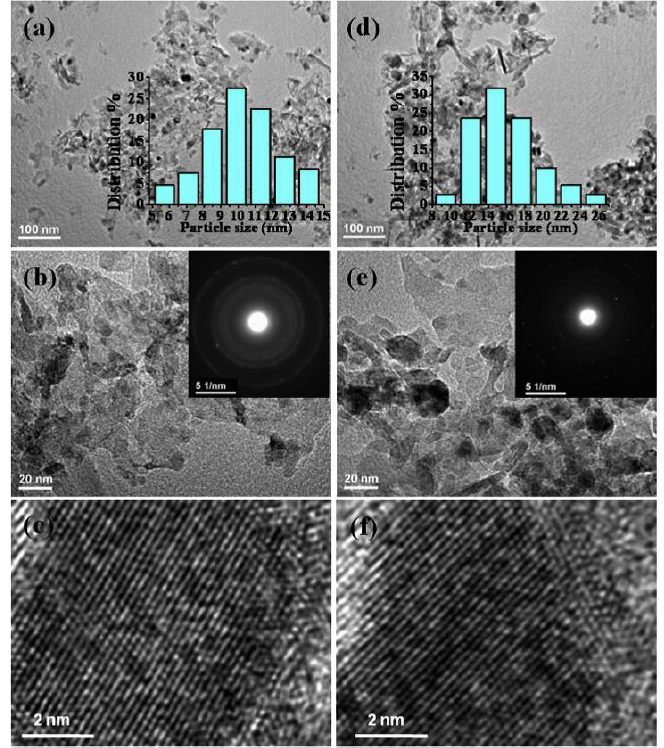
Figure 3. TEM, HRTEM, and SAED patterns of Ni/Al 2 O 3 prepared under MW radiation ( a – c ) and without MW irradiation ( d – f ). Reprinted from Int. J. Hydrogen Energy , 42, Song, F.; Zhong, Q.; Yu, Y.;